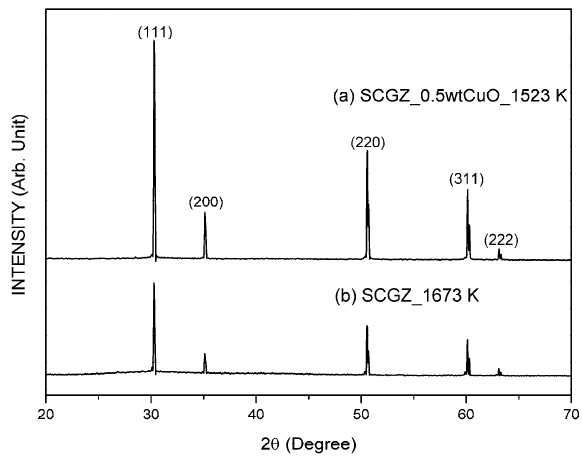
Figure 5. The X-ray di ff raction patterns of ( a ) sintered SCGZ at 1673 K and ( b ) sintered SCGZ with 0.5 wt% CuO at 1523